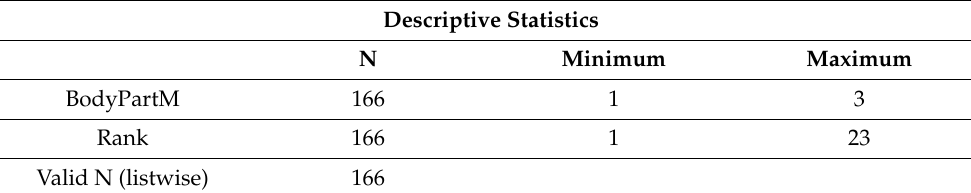
Table 14. Descriptive statistics: minimum and